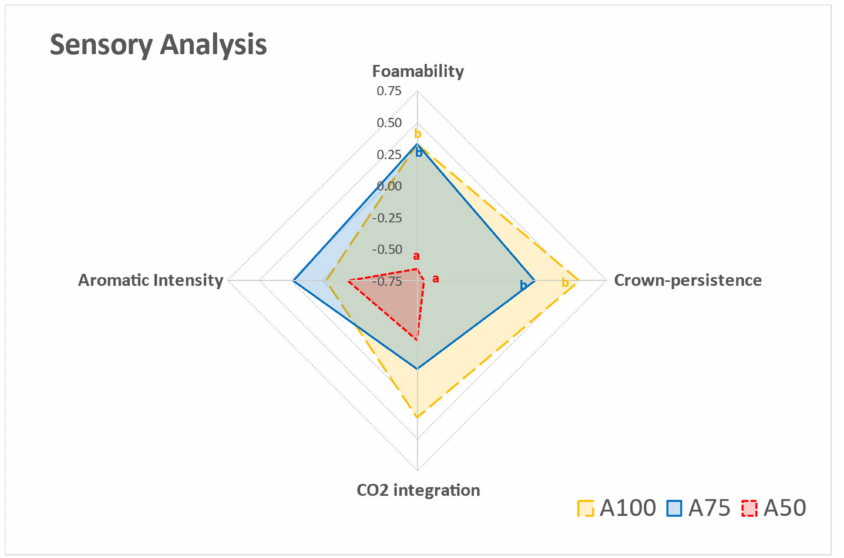
Figure 4. Sensory analysis of the sparkling wines after 9 months of aging on lees from STAGE 3 (A50, A75, A100). Different superscript letters in a sensorial attribute indicate statistically significant differences ( p < 0.05) among the